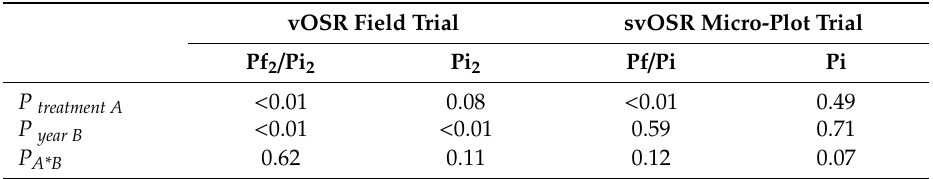
Figure 4. Multiplication rates Pf2/Pi2 (log ( x + 1) transformed left axis; untransformed right axis) of beet cyst nematode (BCN) under volunteer oilseed rape without control (vOSR) and after glyphosate treatment at 250 (vOSR 250 DD) or 350 (vOSR 350 DD) degree days (>8 °C) or permanent control (no plants); means only within years were tested by Fischer LSD Test ( p < 0.05), different letters indicate significant differences. Table 4. Differences in multiplication rates Pf/Pi and initial population densities (Pi) of beet cyst nematode (BCN) as affected by treatments (B) or year (A) and cross- effects (A*B) in a field trial with natural growth of volunteer oilseed rape (vOSR) and a micro-plot-trial with simulated volunteer oilseed rape (svOSR); ANOVA ( p < 0.05) using Log( x + 1) transformed data for each trial separately.